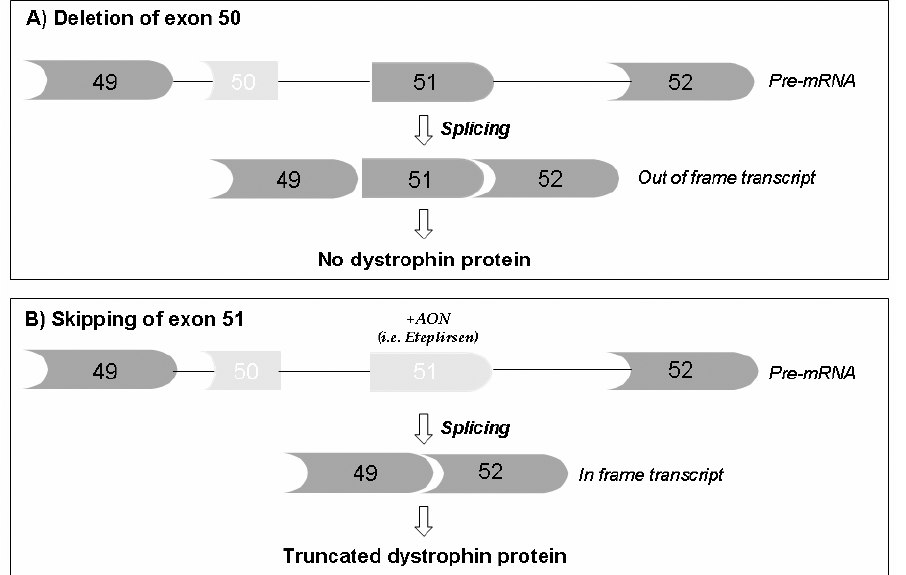
Table 1. Clinical trials (ongoing or recently terminated) evaluating exon skipping induced by AON treatments in DMD patients